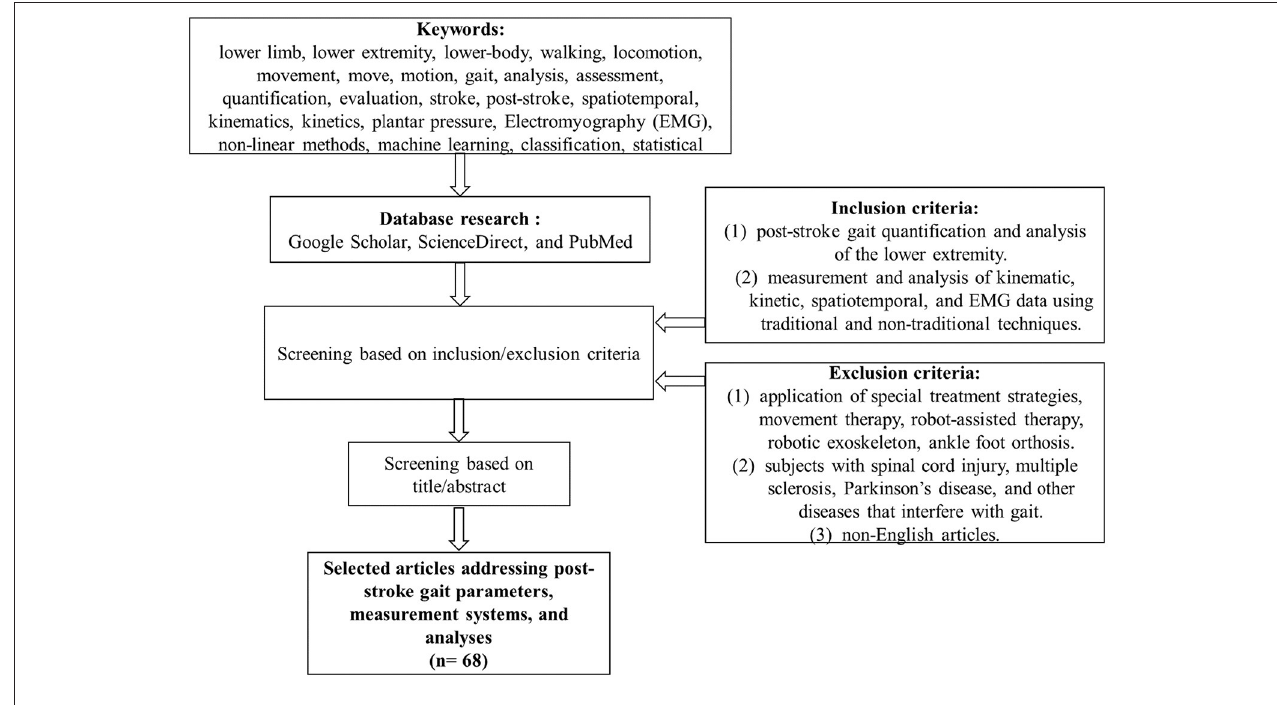
FIGURE 1 | Flowchart of the search.